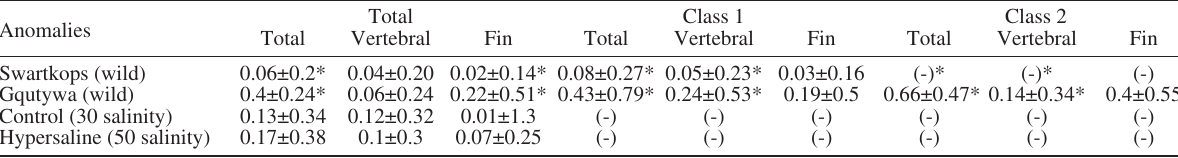
Table 2. – Comparison of the mean (±SD) number of total, vertebral-related and fin-related anomalies found in juvenile Rhabdosargus holubi from the Swartkops and Gqutywa estuaries (n=50 total each) and grown in aquaria at a control 30 and hypersaline 50 salinity treatment (n = 60 total each). For wild-caught fish, size class 1 included individuals of 38 to 60 mm total length, while size class 2 included individuals of 61 to 104 mm total length. The samples from the Swartkops Estuary did not contain enough fin anomalies for specific size class comparisons. An asterisk (*) shows statistical differences (p<0.05) between treatments of a Mann-Whitney U test.